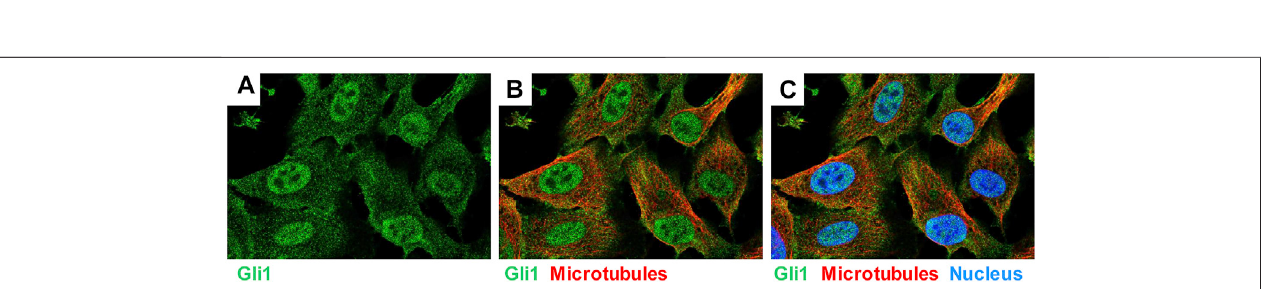
FIGURE 10 | Expression of GLI1 in human bone osteocarcoma cell line U-2 OS. The cell line U-2 OS originating from human mesenchymal tumors express large quantities of GLI1 ( green ), which is localized in the nucleus and the cytoplasm. Microtubuli ( red ) and nucleus ( blue ) are stained by a speci fi c antibody or DAPI. The fi gure wascompiledusingimmunocytochemicaldatatakenfromtheHumanProteinAtlasv.20(www.proteinatlas.org/)(Uhlénetal.,2015).Theycanbefoundat:https://www. proteinatlas.org/ENSG00000111087-GLI1/cell#img.